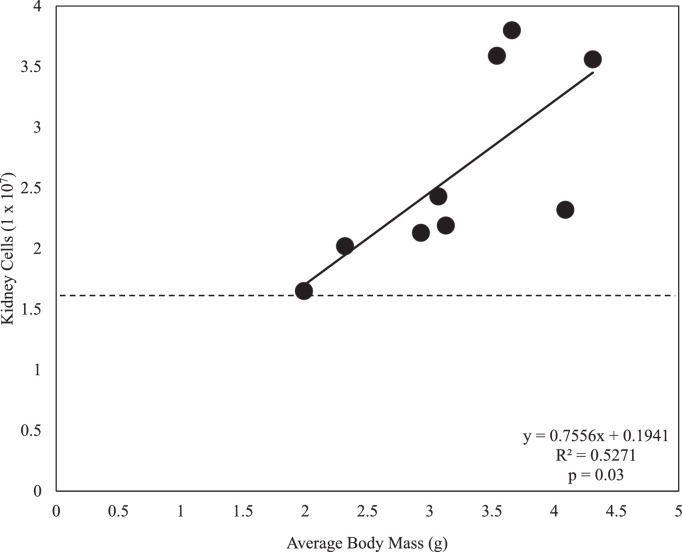
Regression analysis between total body mass and cell yield (n = 9) of adult male fathead minnows. Data in panel may be used to predict kidney cell yield from body mass. Dashed lines represents minimum cell yield required to perform both respiratory burst and phagocytic cell assays as described.